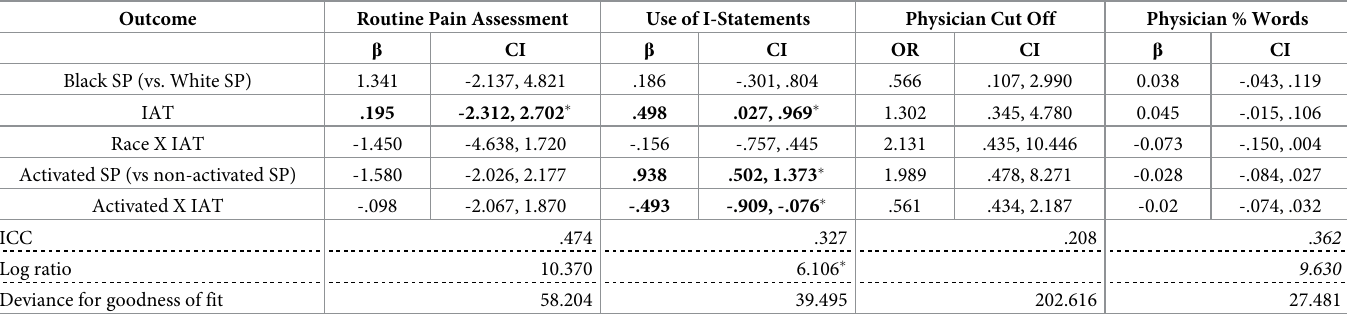
Table 2a. Patient care outcomes: SP race, IAT, and interaction of race and IAT 1 . Outcome Black SP (vs. White SP)